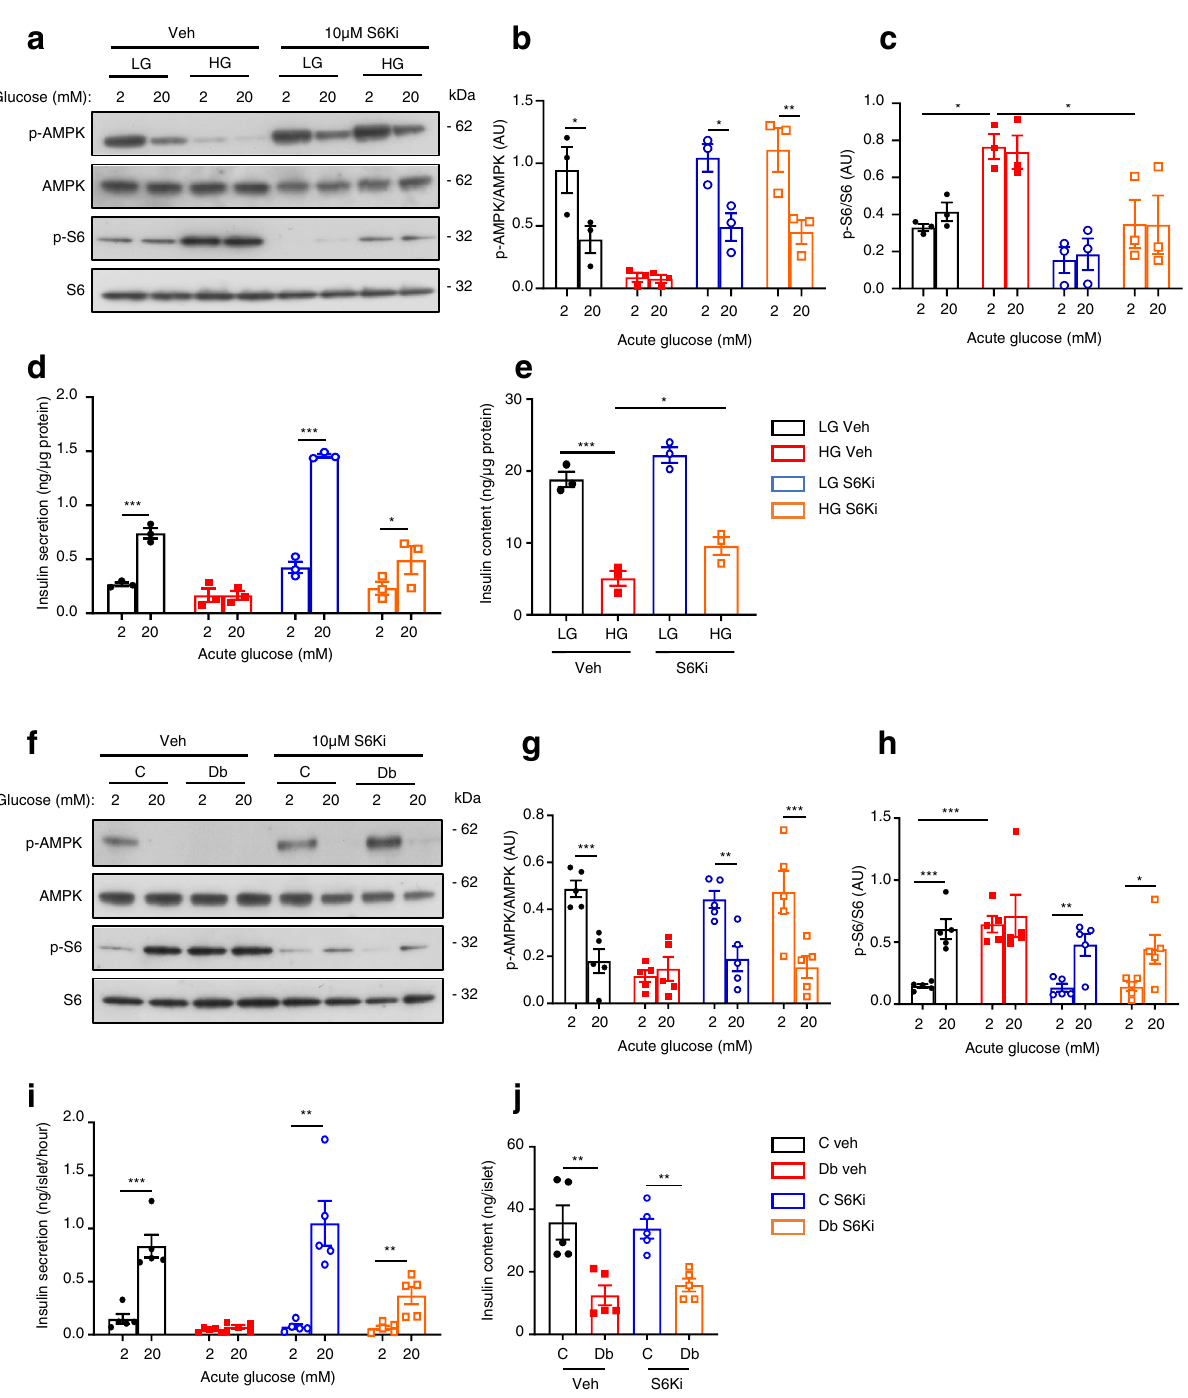
Fig. 7 | S6-kinase inhibition partially reverses the effects of chronic hypergly- caemia. a Representative Western blot of lysates from LG- and HG-cells cultured for 48h±10 µ M of the S6-kinase inhibitor PF-4708671 (S6Ki), and then stimulated with2mMor20mMglucosefor1hintheabsenceofS6Ki.Phosphorylated(p)and totalAMPKandS6.Uncroppedblotsinsourcedata. b , c Quantitativedensitometry analysis of p-AMPK/AMPK ( b , n =3 biologically independent experiments) and p- S6/S6 ( c , n =3 biologically independent experiments). LG-cells (black), HG-cells (red), LG-cells+S6Ki (blue), HG-cells+S6Ki (orange). d Insulin secretion and ( e ) insulin content from LG- and HG-cells cultured for 48h±10 µ M S6Ki and stimu- latedwith 2 or 20mM glucose for 30min in the absenceof S6Ki( n =3 biologically independent experiments). f Representative Western blot of lysates from control